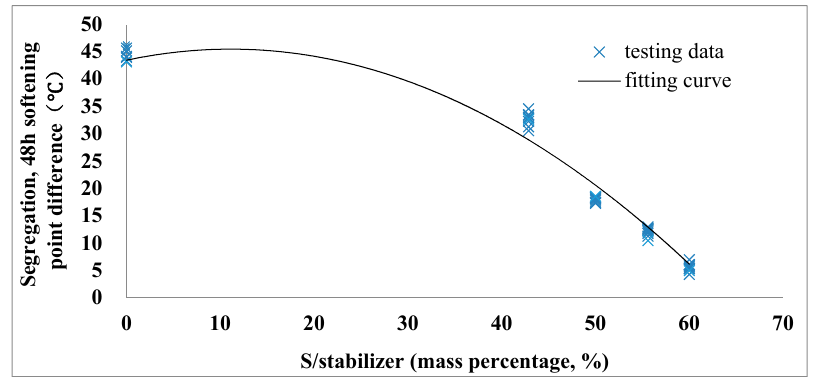
Figure 4. The 48-h segregation softening point with different S content.